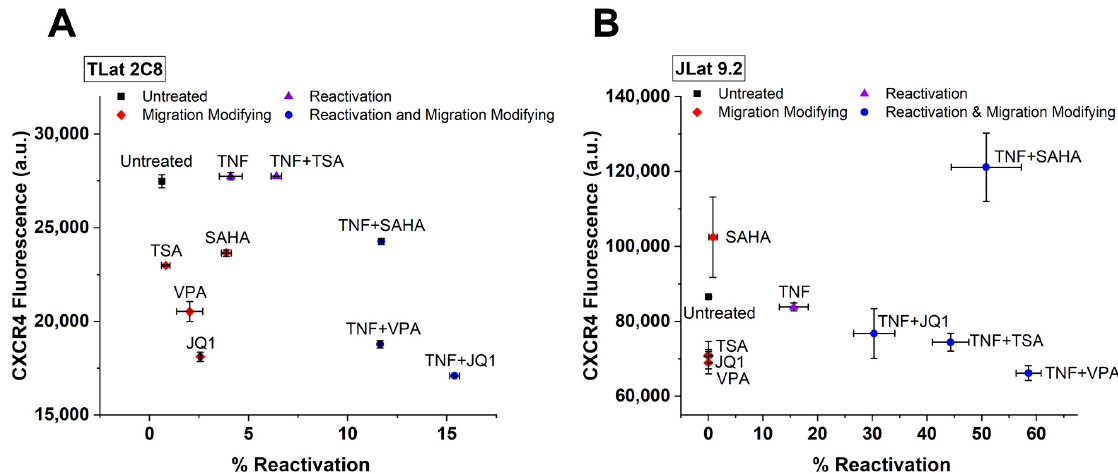
Figure 4. Drug cocktails differentially affect CXCR4 surface expression and reactivation of a latently-infected monocytic cell line. To explore the effects of leading reactivation cocktails on cell migration, CXCR4 surface expression was quantified after 24 h treatment with reactivation cocktails in both ( A ) TLat and ( B ) JLat cell lines. Based on changes in CXCR4 surface expression, the LRA cocktails were classified under three categories: reactivation, migration modifying, and reactivation and migration modifying cocktails (legend). Experiments were performed in duplicate and mean and standard error were